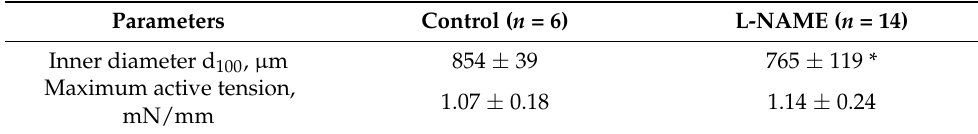
Table 2. Aortic characteristics of 1–2-day-old rat pups from control and L-NAME groups.